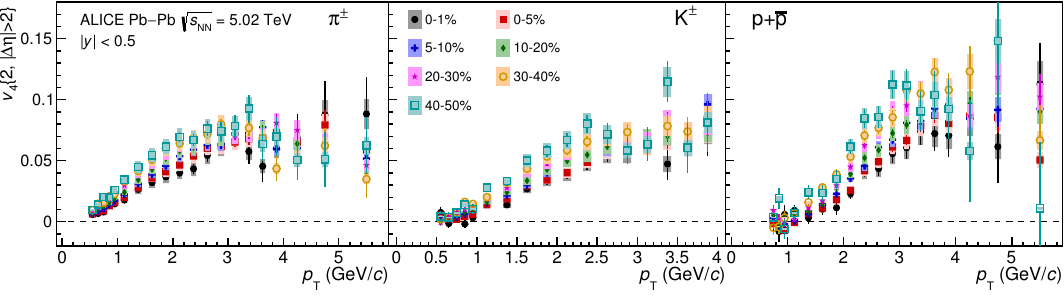
Figure 4 . (Colour online) Centrality dependence of v 4 ( p T ) for (cid:25) (cid:6) , K (cid:6) , and p+p. Statistical and systematic uncertainties are shown as bars and boxes,